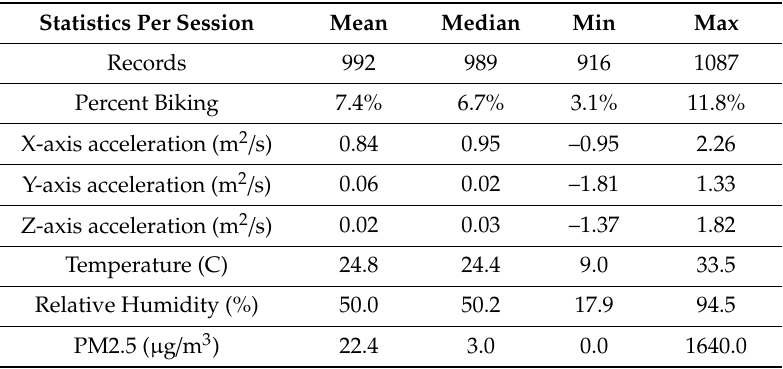
Table 1. Study summary statistics across all 21